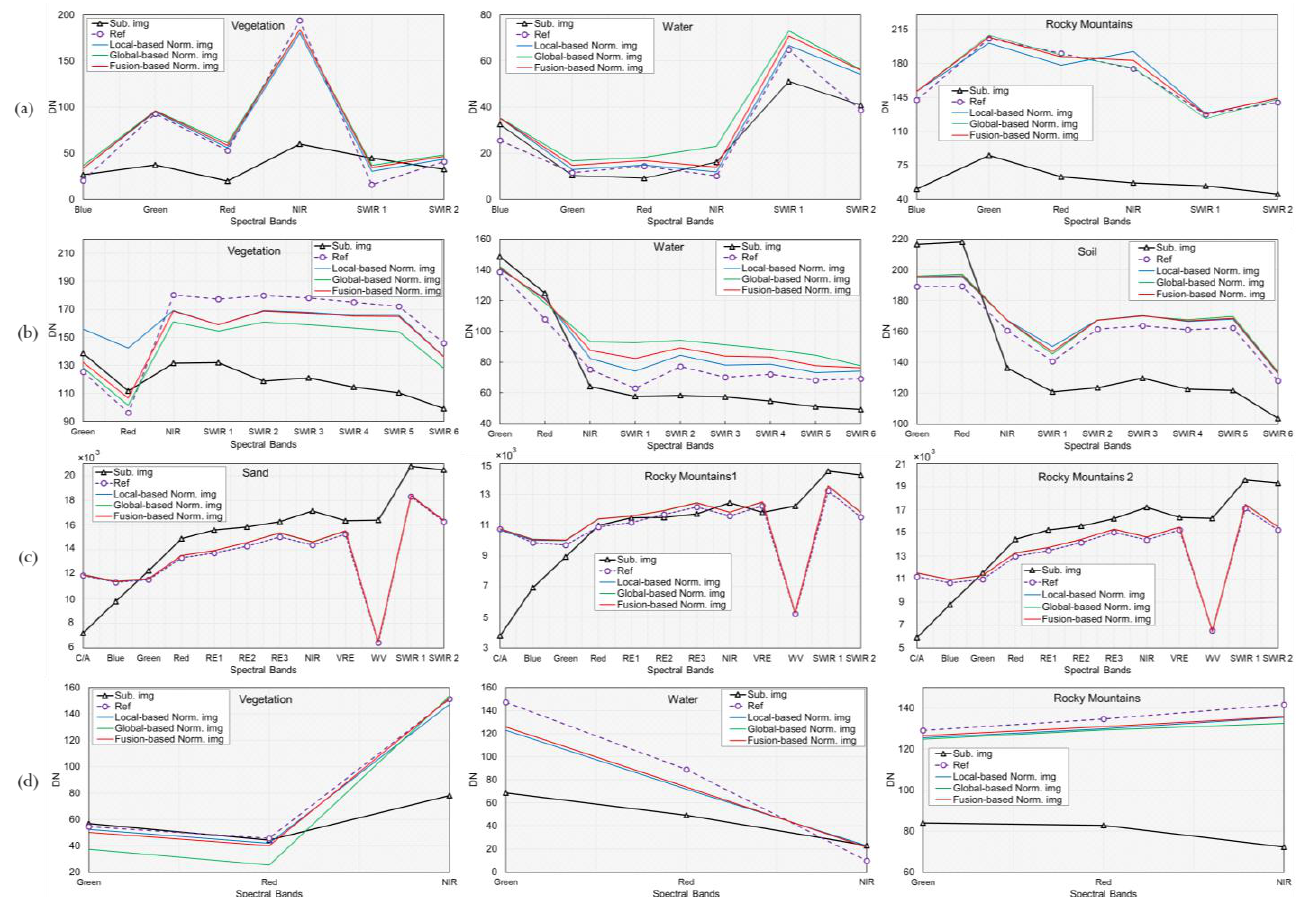
Figure 8. Comparison between the spectral signatures of different LULCs before and after the normalization of datasets 1–4 ( a – d ) with local, global, and fusion RRN modeling.